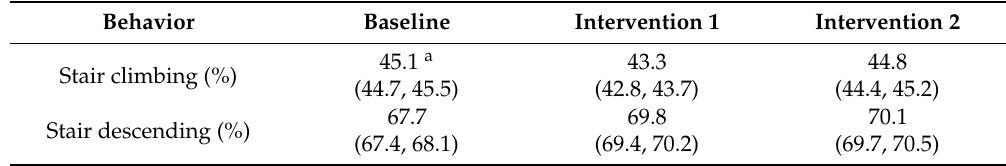
Table 1. Percentage stair use (95% CIs) for the di ff erent intervention phases in the UK.